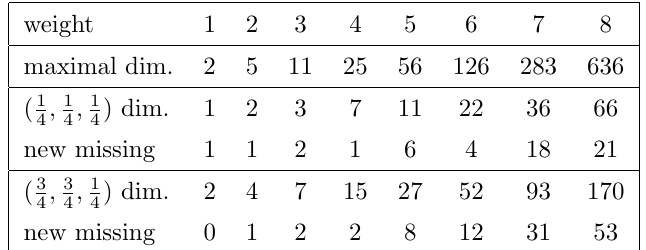
; 1 ; 1 ) and ( 3 ; 3 ; 1 ), 4 4 4 4 4 4